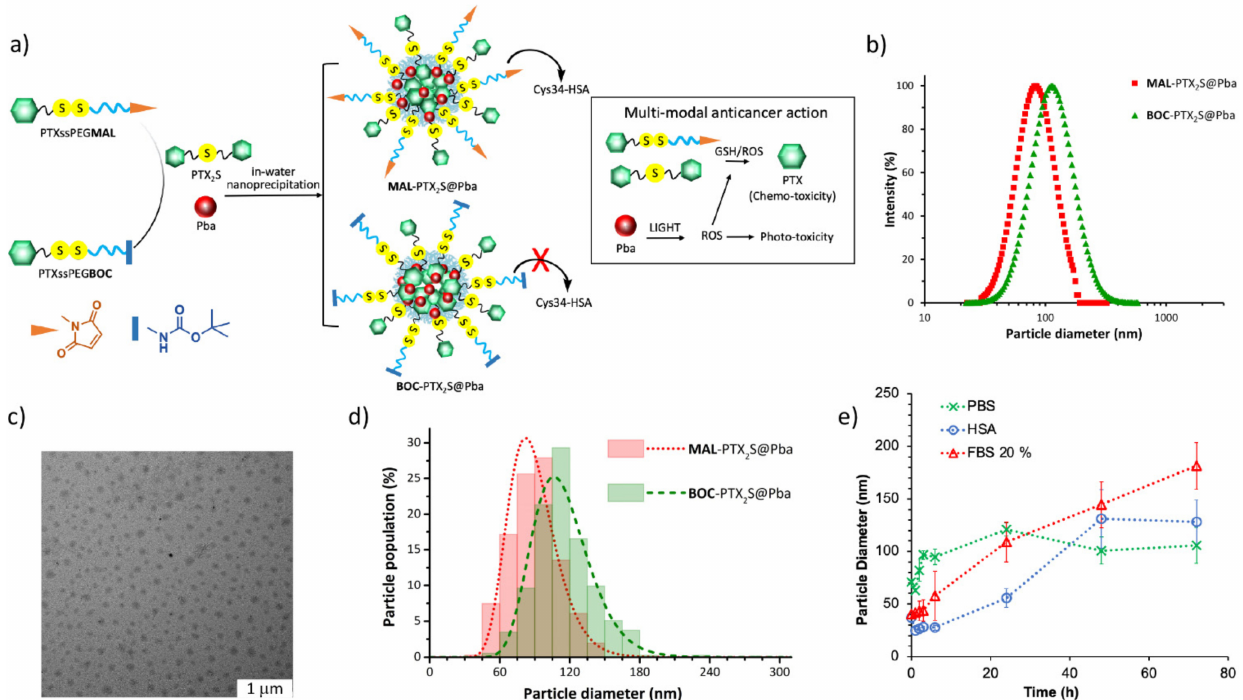
Figure 2. ( a ) Schematic representation of the structure and mode of action of MAL -PTX 2 S@Pba and BOC -PTX 2 S@Pba NPs. ( b ) Representative DLS measurements on MAL -PTX 2 S@Pba (red squares) and BOC -PTX 2 S@Pba (green triangles) NPs. ( c ) TEM analysis of MAL -PTX 2 S@Pba (scale bar 1 µ m). ( d ) Particle size distributions of MAL -PTX 2 S@Pba (red dotted line) and BOC -PTX 2 S@Pba (green dashed line) NPs, as determined by TEM analysis. ( e ) Particle size stability of MAL -PTX 2 S@Pba NPs in PBS pH 7.4 (green dotted line), FBS 20% in PBS pH 7.4, v / v (red dotted line), and HSA 35 mg/mL in PBS pH 7.4, v / v (blue dotted line), as determined by DLS